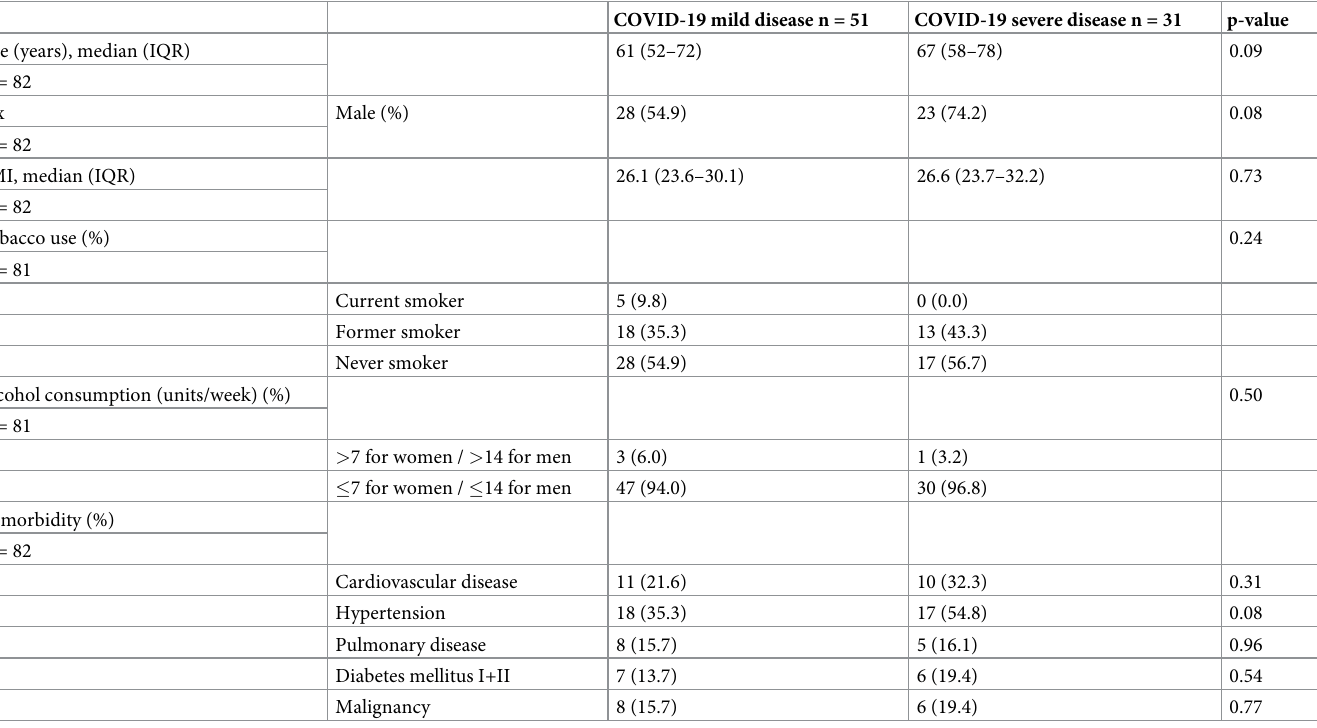
Table 2. Characteristics of 82 patients admitted to Odense University Hospital with COVID-19, of which 31 patients had severe disease defined as either Acute Respiratory Distress Syndrome (ARDS), admittance to intensive care unit and/or death during admission, and 51 patients had moderate disease. COVID-19 mild disease n = 51 COVID-19 severe disease n =